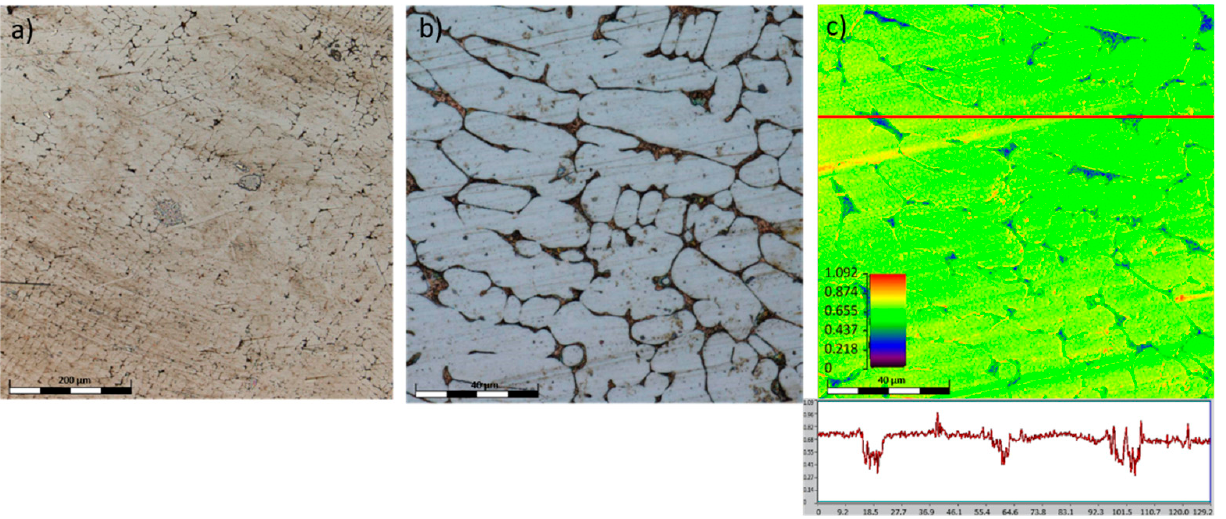
Figure 11. Confocal images of the CoCrFeNiCu surface obtained after the corrosion test: ( a ) low- magnification image, presenting the surface state of the sample, ( b ) high-magnification image, in which the corrosion stains in interdendritic areas are well discernible, ( c ) the color-scaled topography of image b; please note the depth of the periodically occurring corrosion pits.